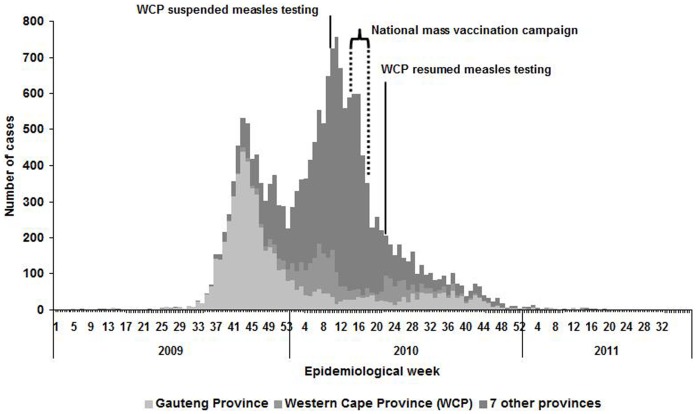
Weekly* number of measles IgM positive cases: South Africa, 2009–2011.* Week calculated from date of specimen collection (n = 17 351), date received (n = 1 067) or date tested (n = 13).